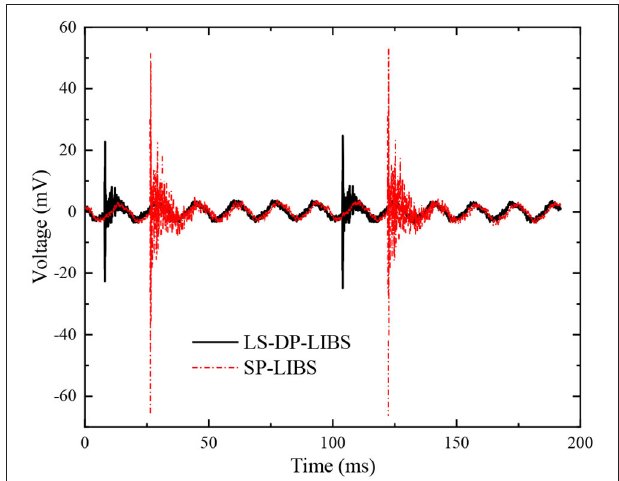
FIGURE 8 | Output voltage of sound sensor during the underwater LIBS